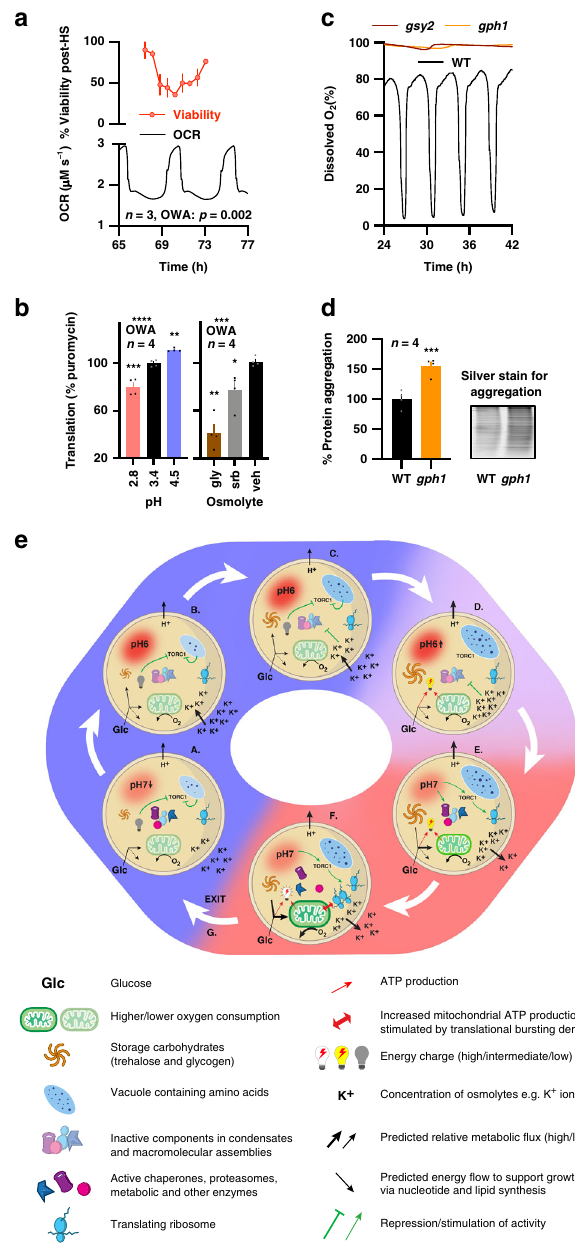
Fig. 5 The YRO regulates resistance to heat stress and protein homoeostasis. a Viability of cells removed from the bioreactor after heat treatment (55 °C, 2 min) is greatest at the end of LOC, when the abundance of trehalose and osmolytes are greatest. Percentage of heat- treated cells, corrected for viability of non-heat-treated cells harvested at the same time (OWA, n = 3 biological replicates). b Sensitivity of HOC protein synthesis rate to pH and hyperosmotic stress assayed by puromycin incorporation (gly, 10% glycerol; srb, 1 M sorbitol, n = 4 biological replicates). c Strains de fi cient in glycogen synthesis ( gsy2 ) or glycogen breakdown ( gph1 ) do not initiate YROs and, d , gph1 strains accumulate aggregated protein, showing that glycogen breakdown is necessary for proteostasis. Representative silver-stained gel (two-sided unpaired t -test, n = 4). e A detailed, testable and experimentally derived model for the YRO. Green arrows/lines represent activation/repression, red arrows represent ATP production/stimulation of ATP production, black arrows represent predicted metabolic fl ux, see key for further details. Data are shown as mean ± SEM. Source data are provided as a Source Data fi